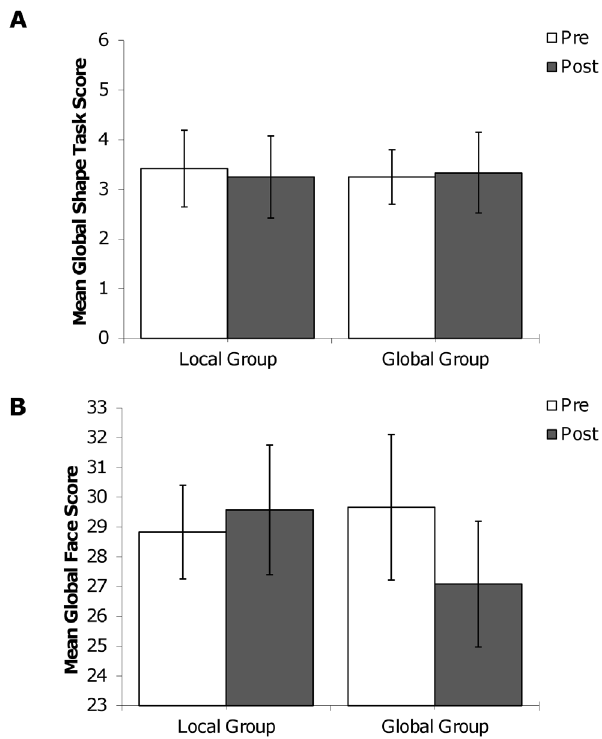
Figure 6. Experiment 3 pattern of means. (a) Experiment 3 mean pre- and post-manipulation global shape task scores as a function of Navon task manipulation group (global or local). (b) Experiment 3 mean pre- and post-manipulation global face scores as a function of Navon task manipulation group (global or local).